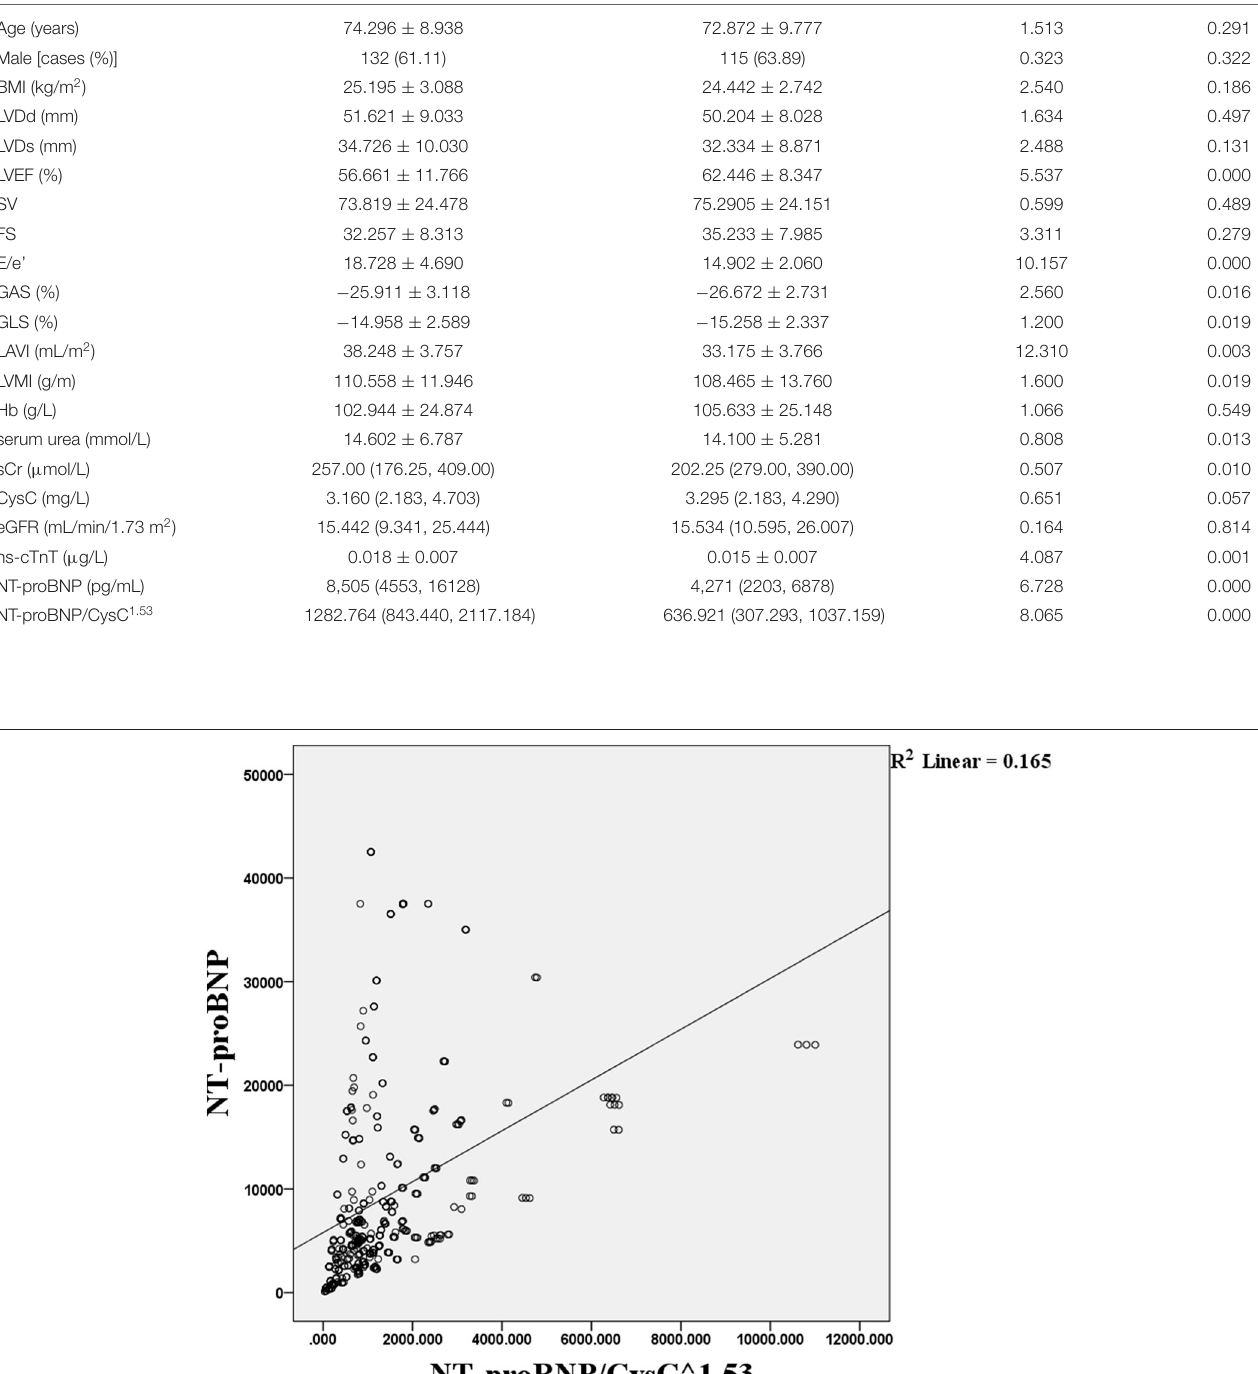
Frontiers in Cardiovascular Medicine |